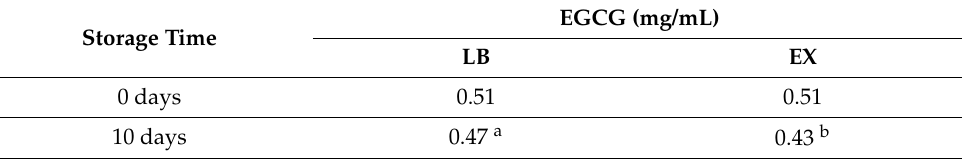
Table 2. Changes of EGCG (mg/mL) in ready-to-drink green tea infusions stored in light-blocking (LB) glass packaging and clear glass light-exposed (EX) packaging under light exposure at 4 ◦ C during 10 days of storage. The concentration (mg/mL) of LB and EX is expressed as means ( n = 2). A significant difference between the two treatments is expressed with different superscript letters (a or b) next to the data ( p <